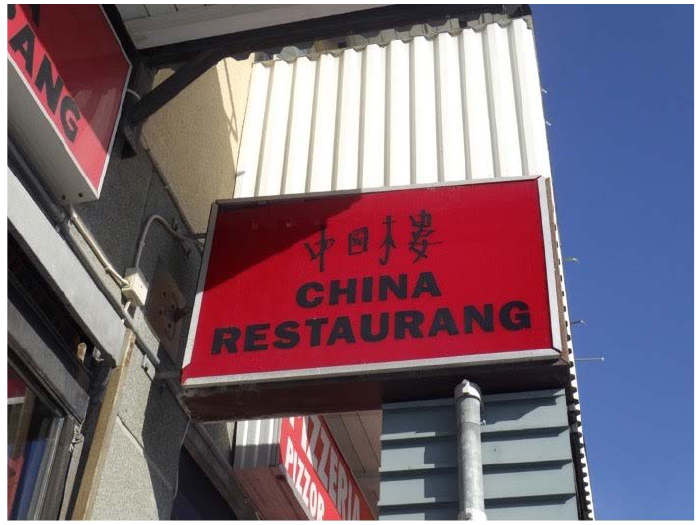
Figure 4. Restaurant Sign